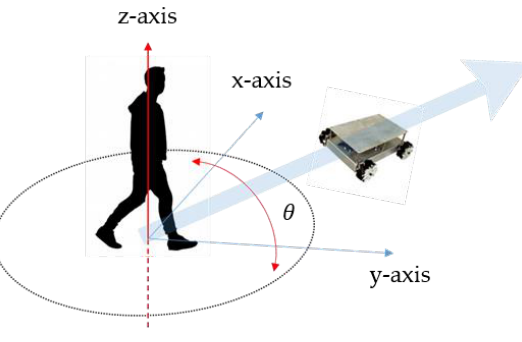
Figure 9. Detection of user rotation.